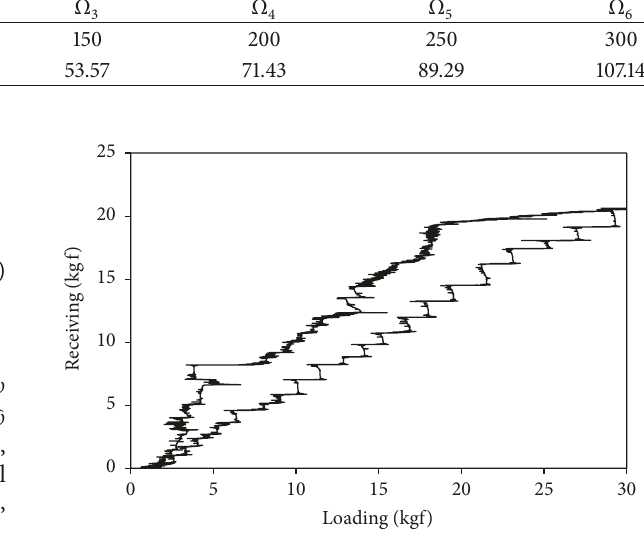
Figure 7: Static axial